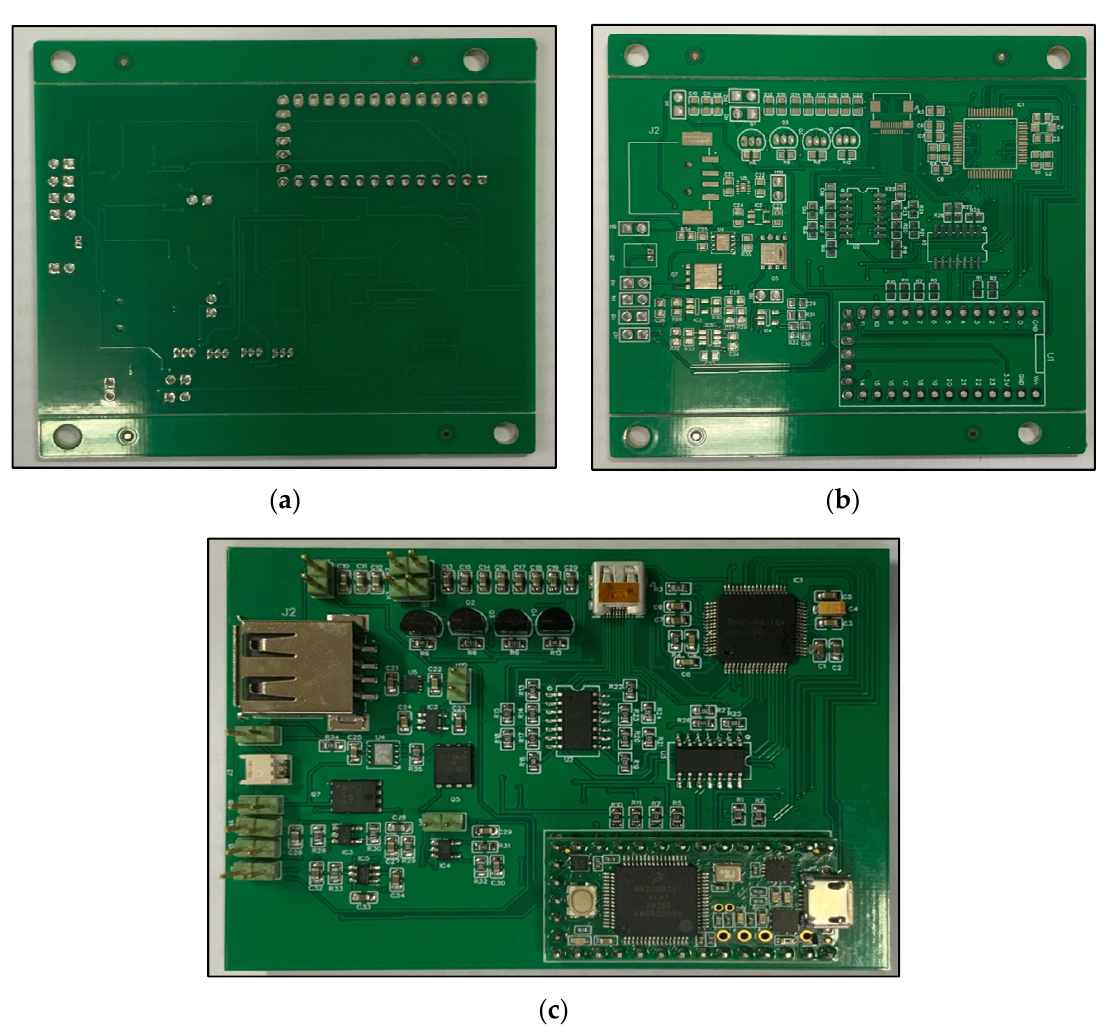
Figure 6. ( a ) Bottom view of the overall EEG/fNIRS system. ( b ) Top view of the overall EEG/fNIRS system. ( c ) Final EEG/fNIRS system.